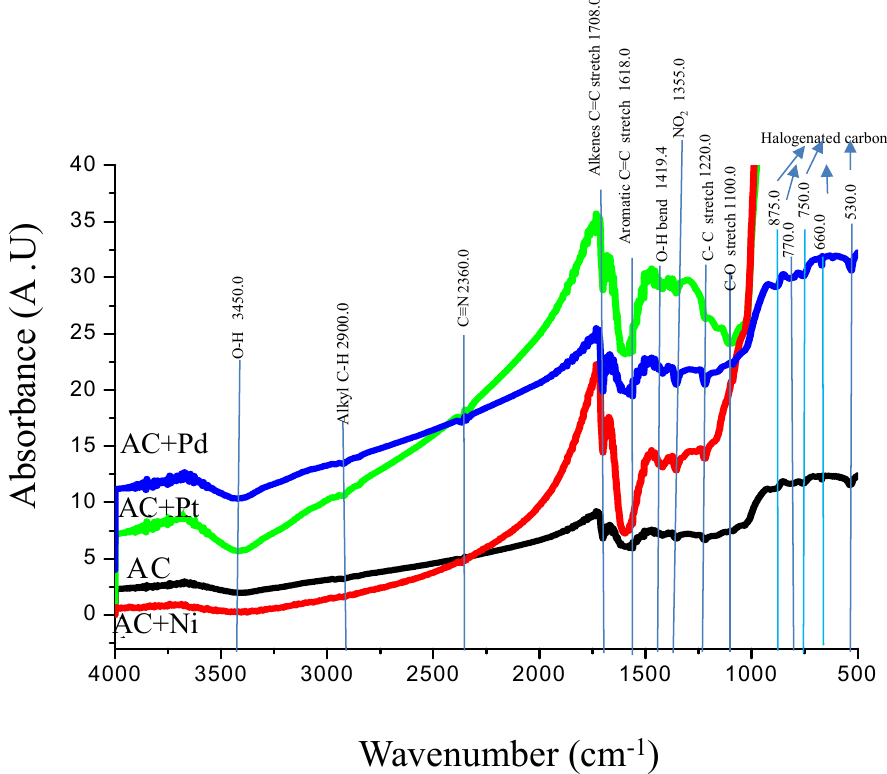
Figure 4. FTIR spectra for activated carbon (AC) and metal-anchored AC + Ni, AC + Pd and AC +